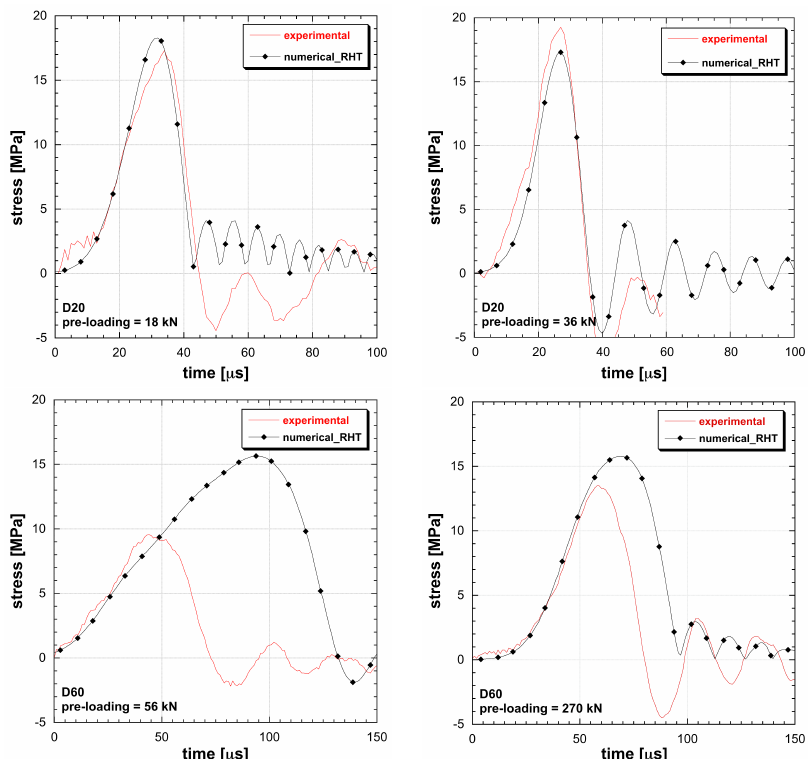
Figure 6. Comparison between experimental and simulated behaviour of UHPC in tension at different loading rate and size (RHT material model).